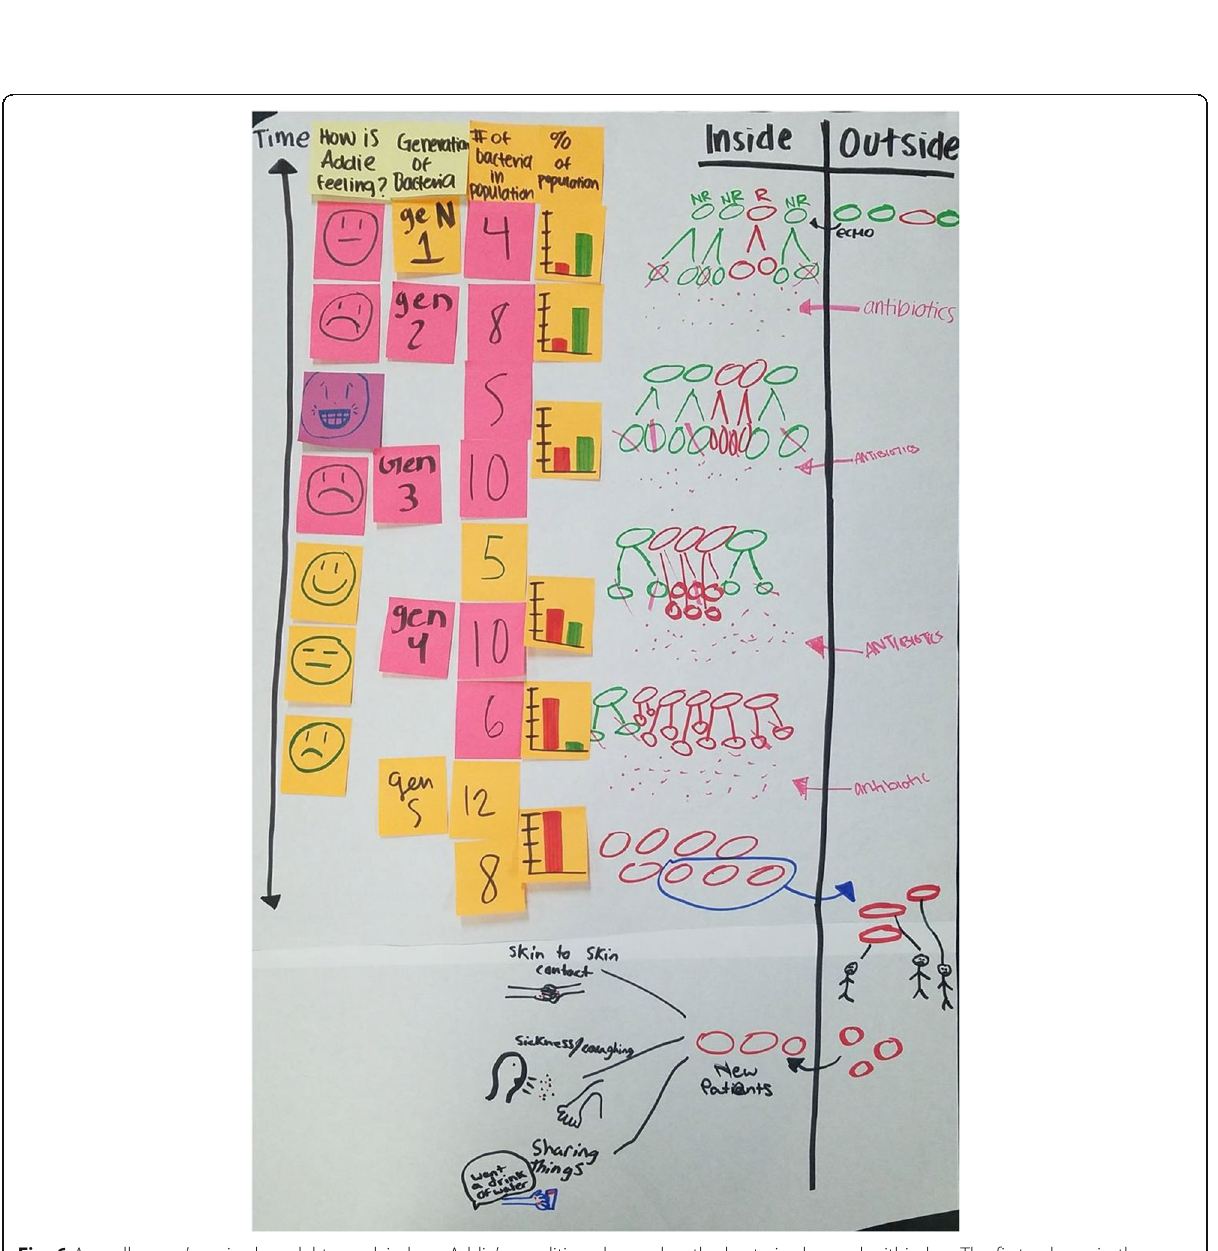
Fig. 6 A small group ’ s revised model to explain how Addie ’ s condition changed as the bacteria changed within her. The first column in the model shows how Addie is feeling as time elapses. The next column marks the generation of bacteria. The numbers in the next column indicate the relative size of the bacteria population as a whole, followed by a graph of the proportion of the resistant bacteria (labeled R in the diagram, the red bar in the graph) and nonresistant bacteria (labeled NR in the diagram, represented by the green bar in the graph) in the population. The graph and numbers reflect the step-by-step model that students drew out mapping the bacteria inside Addie ’ s body. An X on the bacterium means the antibiotic killed the bacterium. A branch means the bacterium divided. Of course only surviving bacteria reproduced. The number in the next generation is the number of bacteria minus the ones that died after the survivors